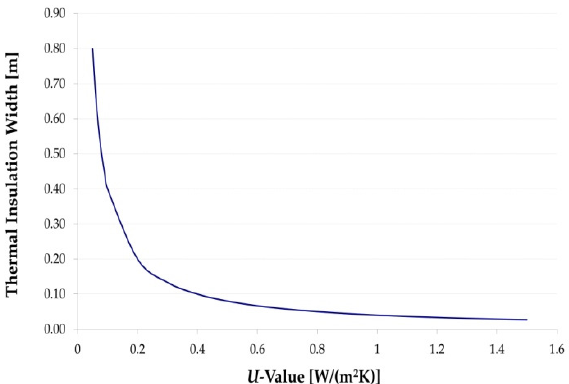
Figure 3. The course of function U = 1/( R si + d / λ + R se ) for λ = 0.04 W/(m.K) and d = thermal insulation width as variable, while internal and external surface resistances ( R si and R se ) were neglected for the sake of